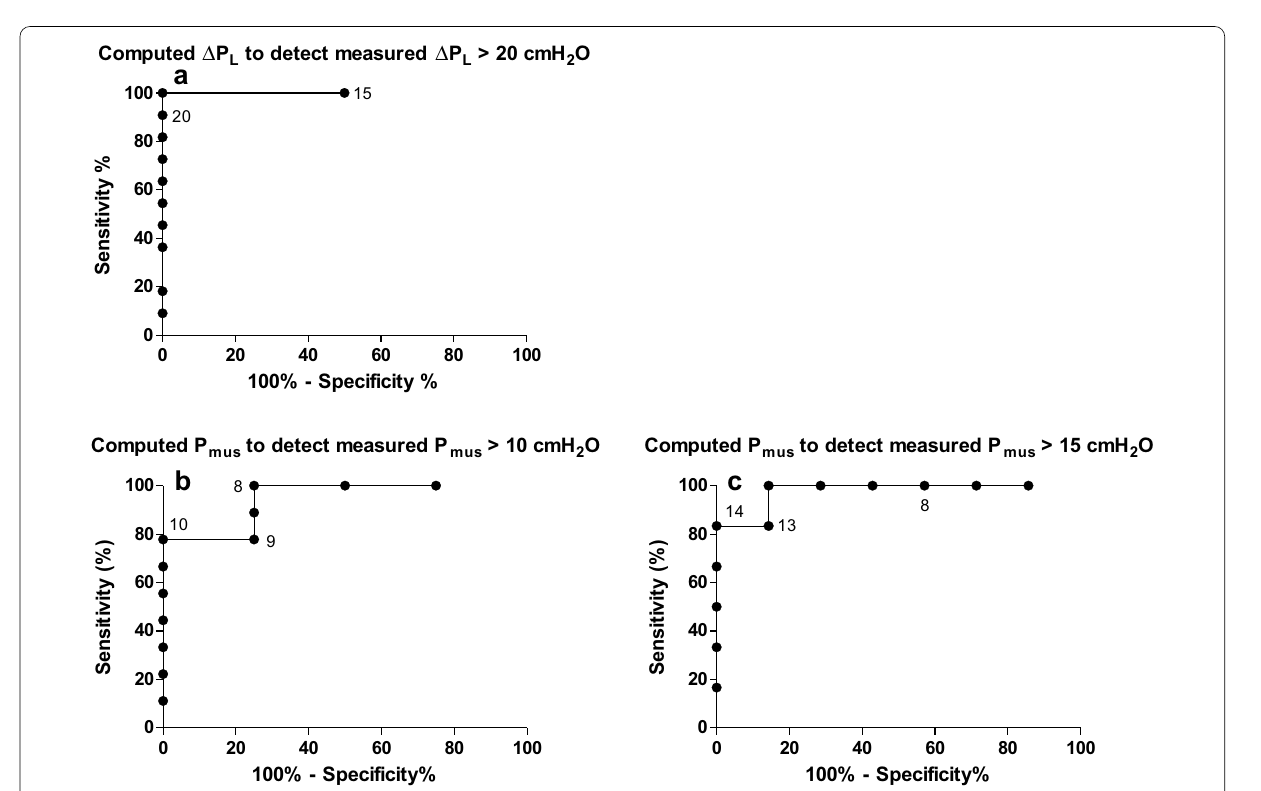
Fig. 3 Receiver operating characteristic curves (ROC) showing the discriminative performance of computed transpulmonary driving pressure (∆ P L ) to detect measured excessive (> 20 cmH 2 O) ∆ P L [area under the ROC (AUROC) 1.00 (95% confidence interval (CI), 1.00–1.00)] ( a ) and computed respiratory muscle pressure ( P mus ) to detect measured P mus > 10 cmH 2 O [AUROC 0.94 (95% CI, 0.81–1.00)] ( b ) and 15 cmH 2 O (AUROC 0.98 (95% CI, 0.90–1.00)] ( c ). Threshold values are shown as points on the